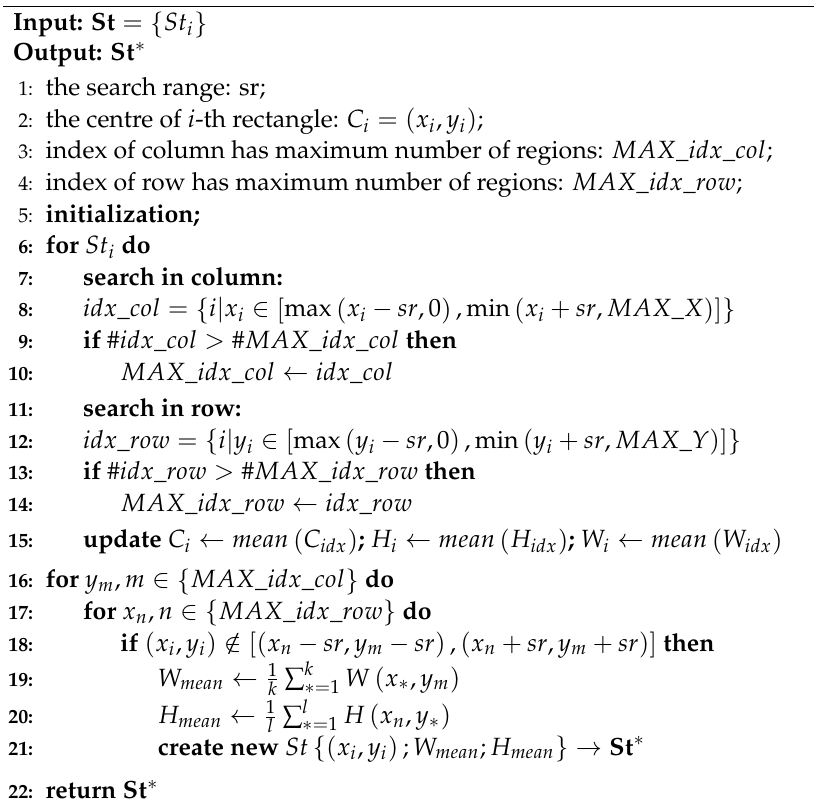
Algorithm 2 Region resizing and Rearrangement